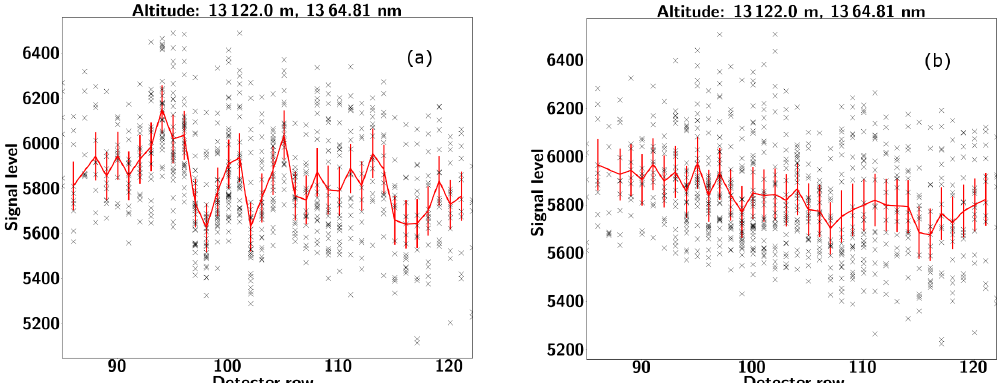
Figure 15. Observed systematic inter-sample variability in the measured spectra for a single wavelength (1364.81nm) and altitude (13.122km) (a) . The same information is plotted in (b) after the secondary correction is applied. The error bars denote Poisson noise and the average SNR of the measurements for this set of samples is